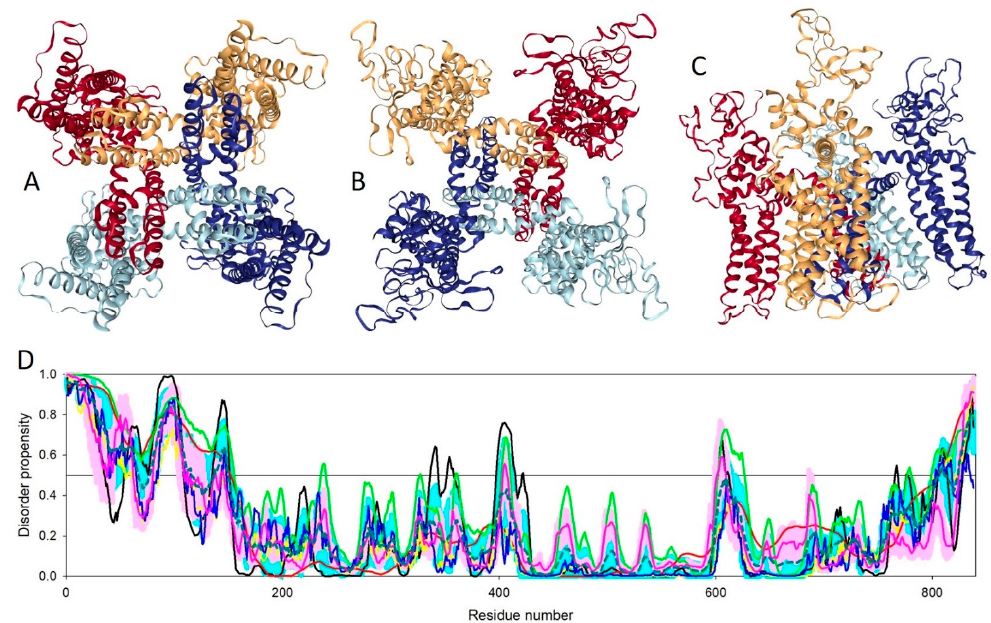
Figure 5. Three projections of the 3D structure of the deletion mutant of rat TRPV1 resolved by single ‐ particle cryo ‐ EM (PDB ID: 5IRZ, [133]): A . Cytoplasm view; B . Membrane view; and C . Side view. D . Evaluation of the intrinsic disorder propensity of the full ‐ length rat TRPV1 (UniProt ID: O35433) by a set of commonly used disorder predictors. Presented disorder profiles were generated by PONDR ‐ FIT (pink curve), PONDR ® VLXT (black curve), PONDR ® VSL2 (green curve), and PONDR ® VL3 (red curve) [106–111], as well as two tools from the IUPred web server for predicting short and long disordered regions (blue and yellow curves, respectively) [112]. The dark cyan dashed line shows the mean disorder propensity calculated by averaging the disorder profiles of the individual predictors. The light pink shadow around the PONDR ® FIT shows error distribution, whereas the light cyan shadow around the mean disorder curve reflects the distribution of the standard deviations. In these analyses, the predicted intrinsic disorder scores above 0.5 are considered to correspond to the disordered residues/regions, whereas regions with disorder scores between 0.2 and 0.5 are considered flexible.